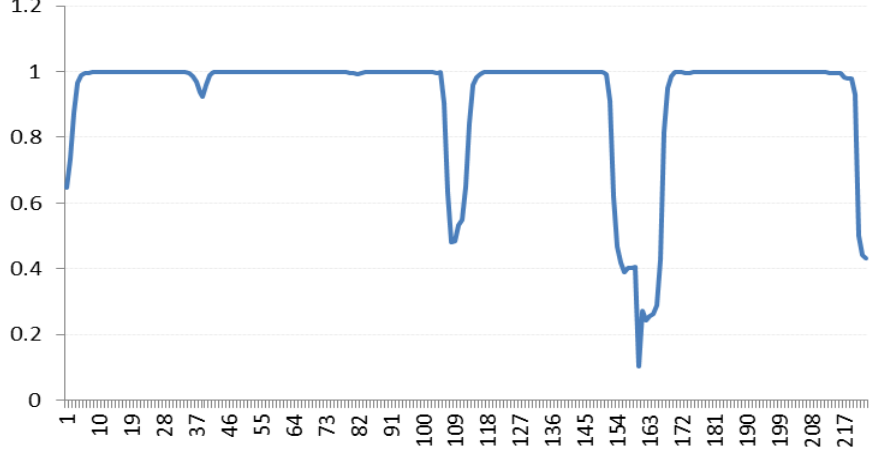
Figure 17. Average scene correlation for continuous band for Low